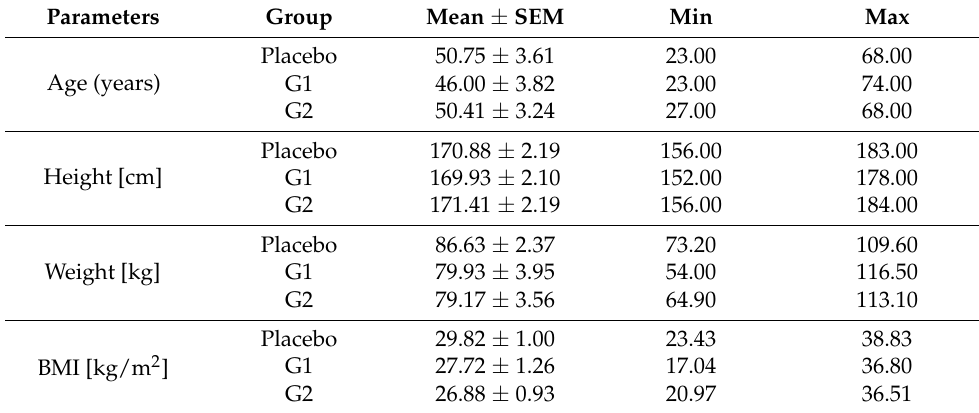
Table 1. Age and anthropometric parameters of study population (mean ±